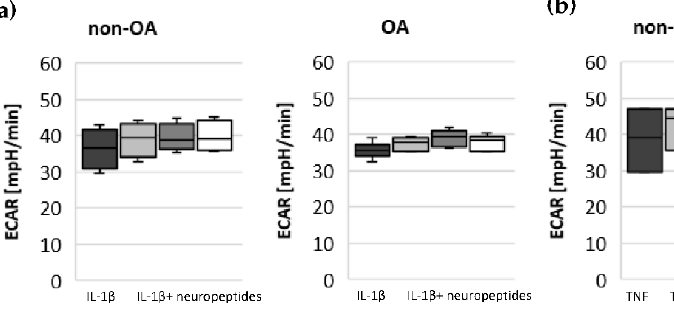
Figure 8. Impact of opioid neuropeptides on glycolytic activity measured by ECAR after stimulation with ( a ) IL-1 β and opioid neuropeptides (non-OA patients = 4, OA patients = 6) and ( b ) TNF and opioid neuropeptides (non-OA patients = 3, OA patients = 5). Values are displayed as box plots. Statistics: Kruskal–Wallis test; no significant differences were found within the groups. ECAR: extracellular acidification rate.